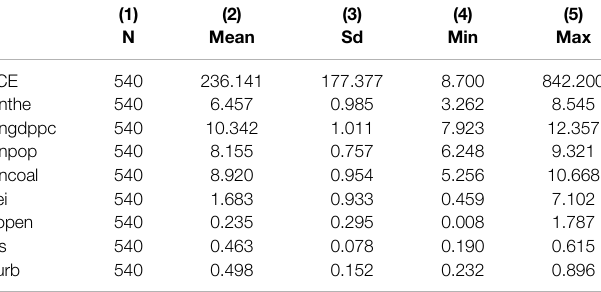
TABLE 2 | Descriptive statistics for key indicators.